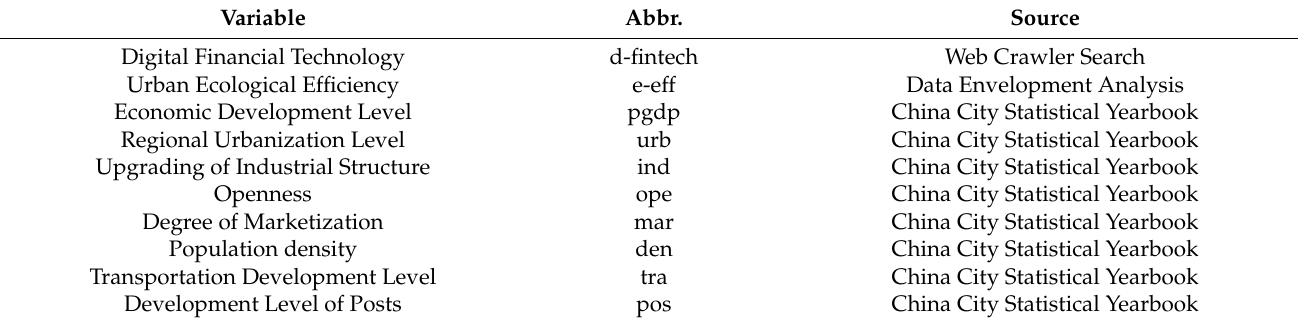
Table 1. Variable data